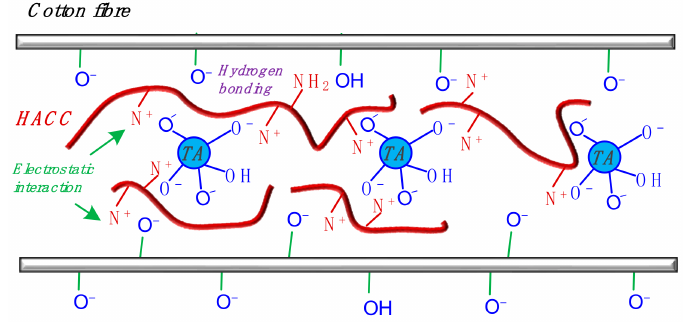
Figure 8. Proposed triple interactive scheme for HACC, TA, and cotton fibres.